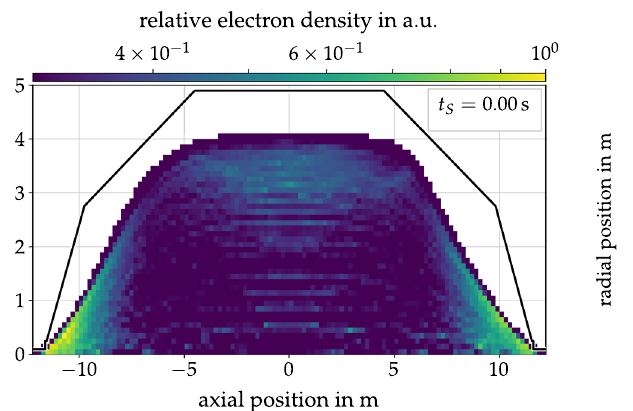
( t S = 0 s) is almost homogeneous in the flux tube volume. Right: at inverted magnetic field ( t S = 0 . 5 s), the flux tube is strongly deformed and electrons are removed from the nominal flux tube, resulting in regions with reduced density. A region around the spectrometer cen- ter ( | z | (cid:2) 5 m) remains where electrons are stored despite the inverted